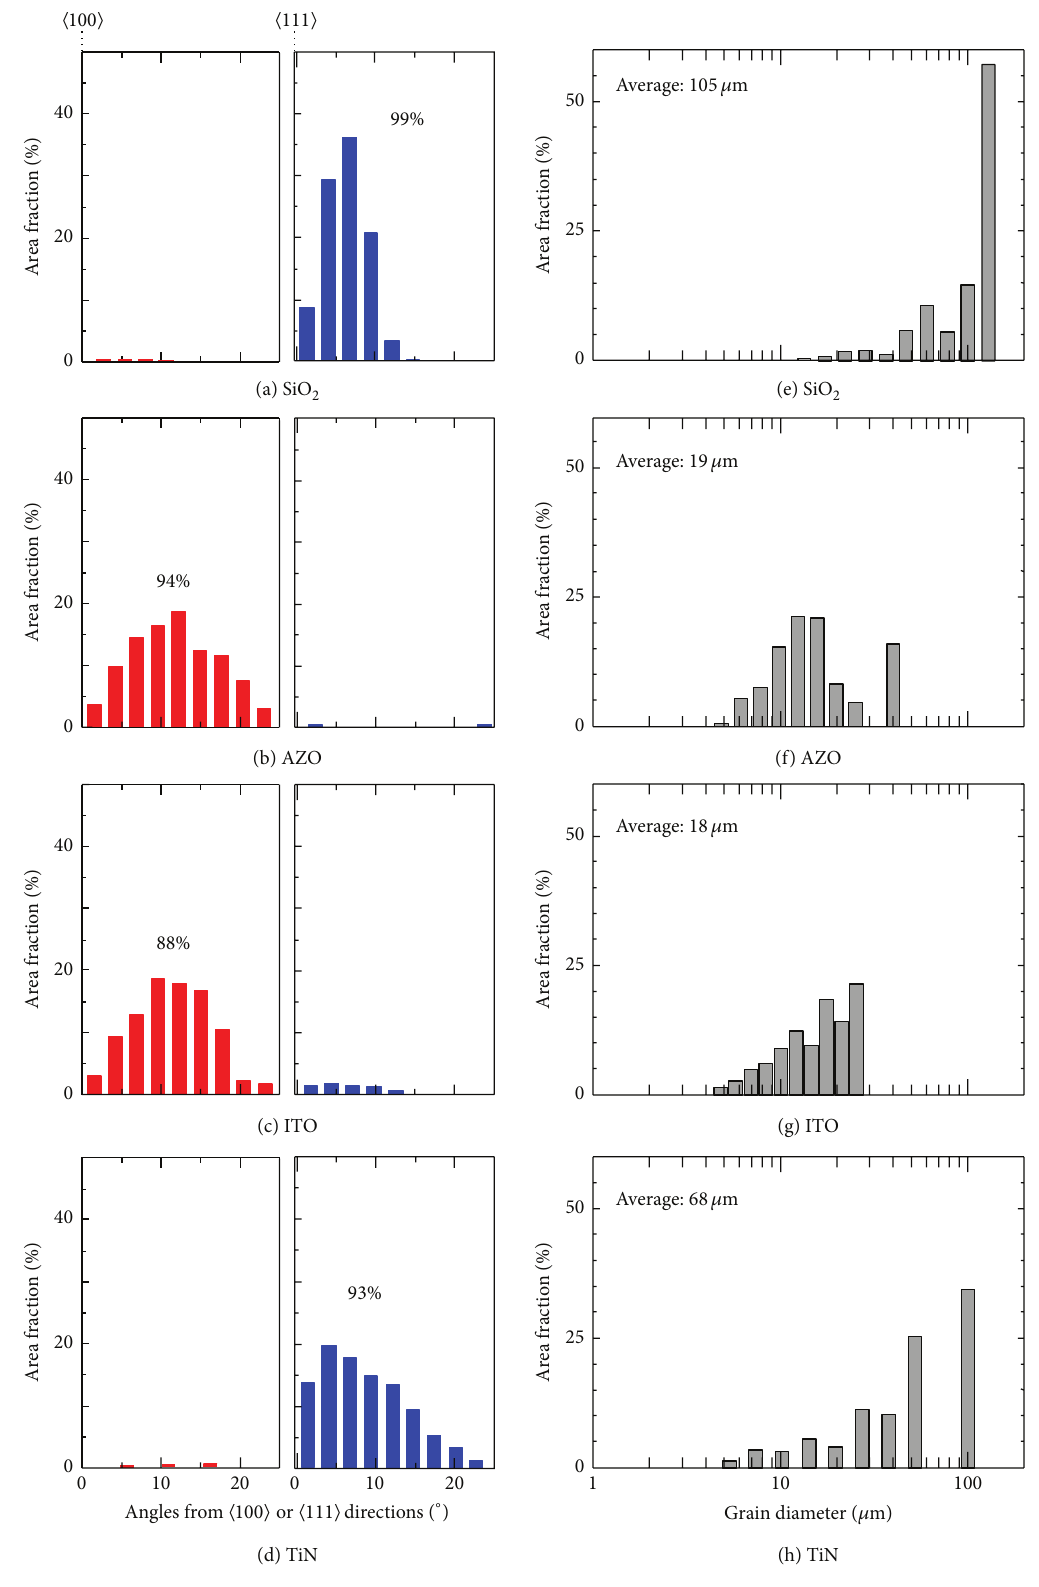
Figure 4: Distribution histograms of the (a)–(d) crystal orientation fraction and the (e)–(h) grain size in the poly-Si layers with SiO 2 , AZO, ITO, and TiN underlayers. These histograms were obtained from the orientation maps shown in Figure 3. The integrated values of the preferentially oriented area fraction from 0 ∘ to 20 ∘ are shown in (a)–(d); the average grain sizes are shown in